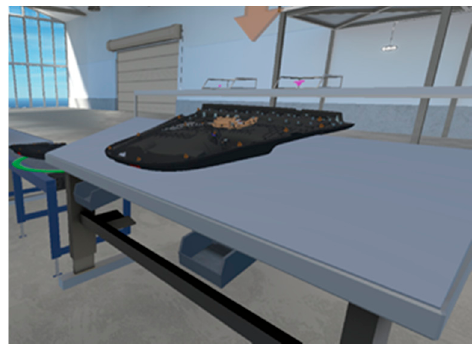
Figure 8. The workplace after rationalisation .